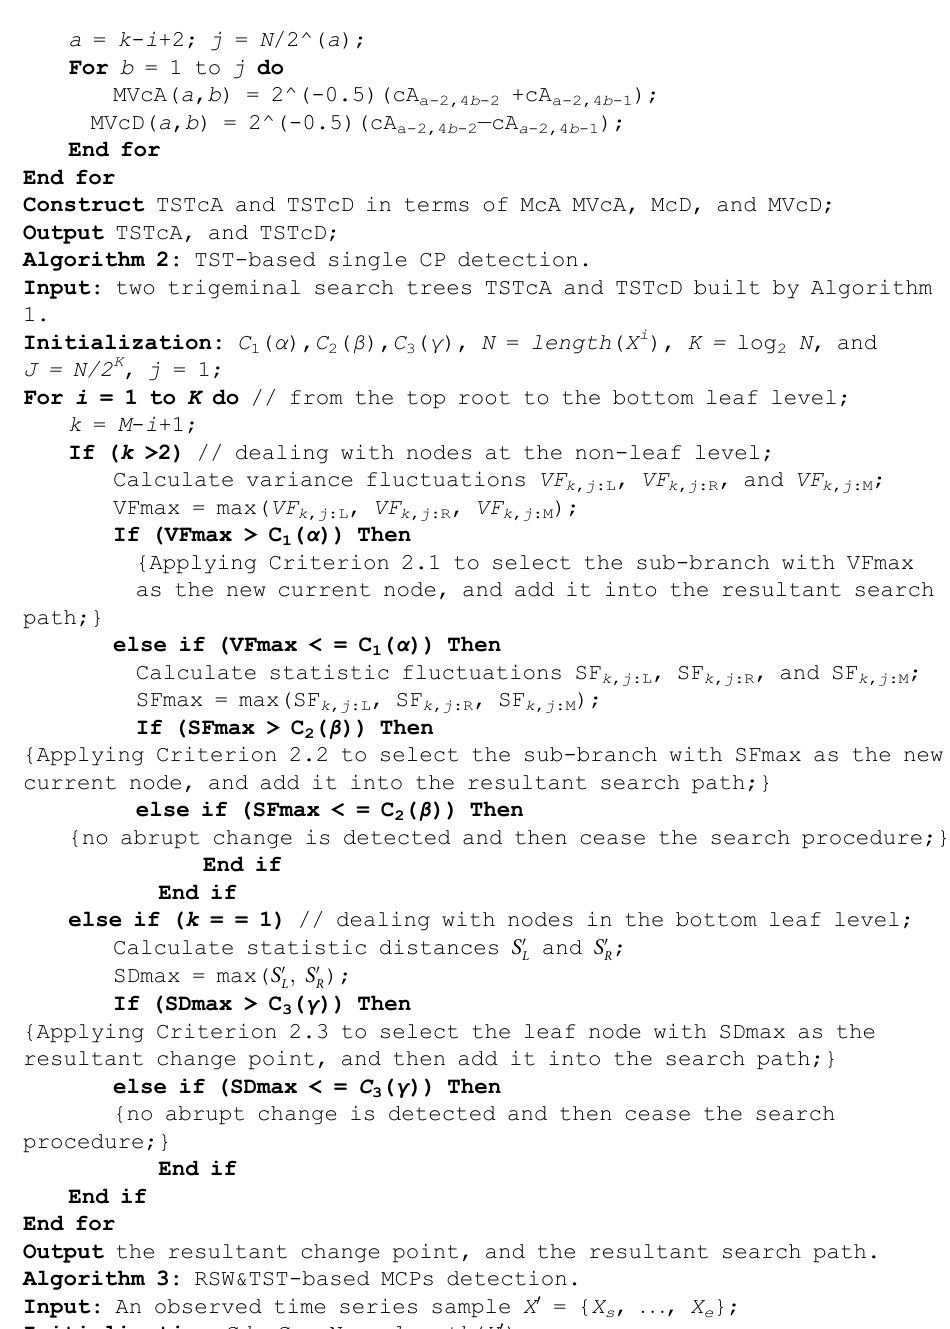
Algorithm 3: RSW&TST-based MCPs